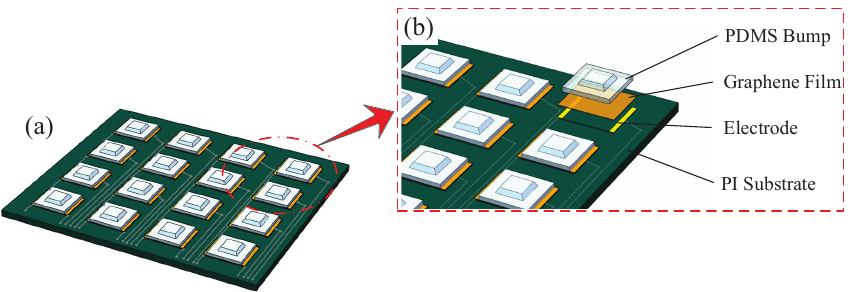
Figure 2. Structure of the electronic skin ( a ); Partial enlarged detail of the electronic skin ( b ).